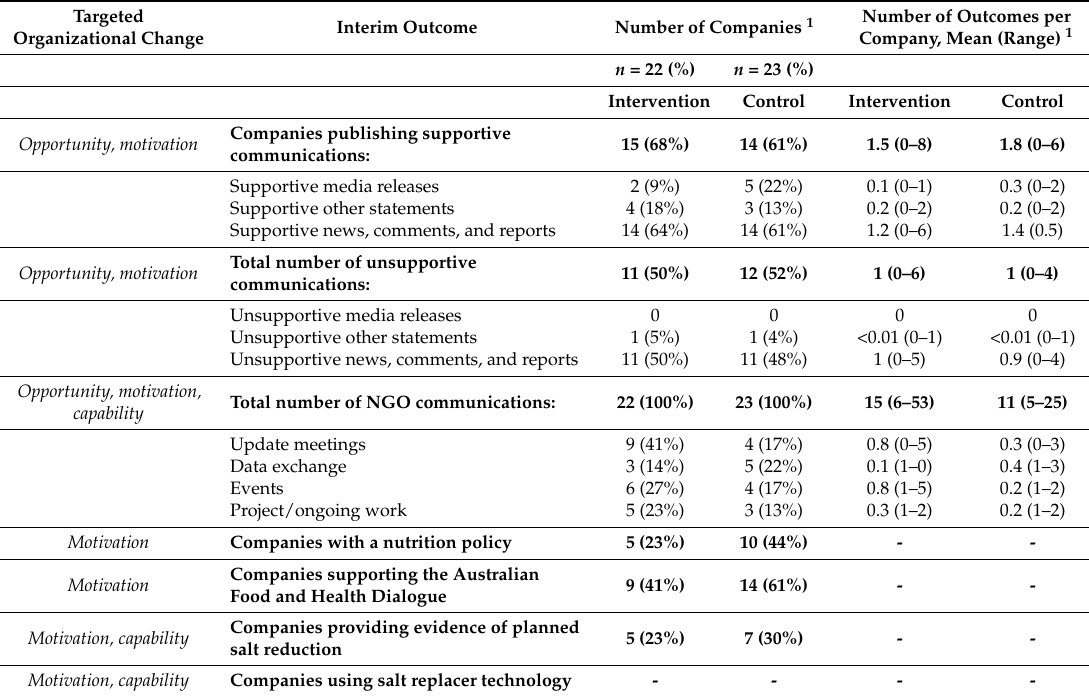
Table 3. Comparison of intervention and control group interim